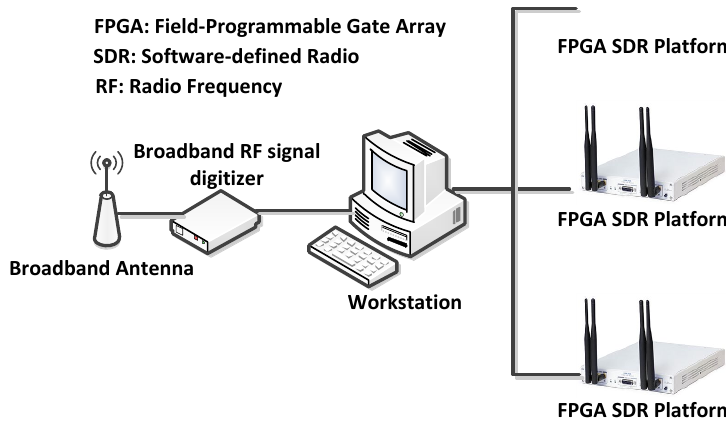
Figure 2. Master–slave auto-modulation classification architecture in which neural network training is completed in the workstation.